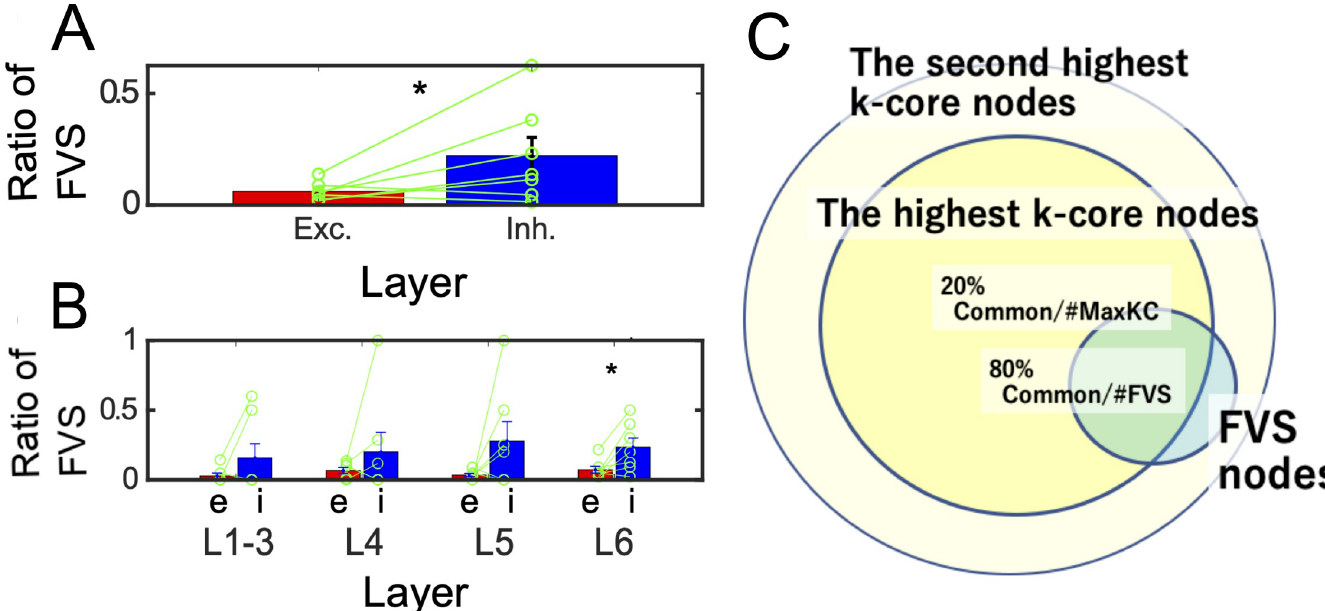
Fig 7. E/I cell category and FVS (Feedback Vertex Set) : A shows the difference of ratios of FVS for excitatory (or inhibitory) neurons. Ratios of FVS for excitatory (or inhibitory) neurons are defined as ratios of number of excitatory (or inhibitory) FVS neurons per the number of all excitatory (or inhibitory) neuron pools. The E/I difference also showed significant difference (p < 0.05, Wilcoxon signed rank test (one sided), FVS(excitatory): 0.059 ± 0.001vs. FVS(inhibitory): 0.226 ± 0.053; Z (7 slices) = 8.3). B shows the result of the same statistical tests separately applied to different layers (Wilcoxon signed rank test). We plotted � mark if significant difference existed (p < 0.05, Wilcoxon signed rank test (one sided), Layer2-3: FVS(excitatory): 0.027 ± 0.003vs. FVS(inhibitory): 0.16 ± 0.07; Z (7 slices) = 4.7, p = 0.5; Layer4: FVS (excitatory): 0.067 ± 0.004 vs. FVS(inhibitory): 0.20 ± 0.14; Z (7 slices) = 2.6, p = 0.44; Layer5: FVS(excitatory): 0.034 ± 0.001 vs. FVS(inhibitory): 0.28 ± 0.13; Z (7 slices) = 4.8, p < 0.16; Layer6: FVS(excitatory): 0.069 ± 0.003 vs. FVS(inhibitory): 0.26 ± 0.05; Z (7 slices) = 10.1, p < 0.05). Here, while Layers 1 to 5 didn’t have any significant difference between the FVS ratios for ratio of FVS nodes among excitatory and FVS ratios for inhibitory neurons, we could find significantly more inhibitory FVS nodes in Layer 6. All error-bars in panels A and B express standard errors. C The Venn diagram expresses how FVS nodes and nodes having highest k-core value overlap each other. About 80% of FVS nodes have the highest k-core value , and about 20% of nodes having the highest k-core value are categorized as FVS nodes . All FVS nodes were included in the group of nodes having the k-core values more than the second highest